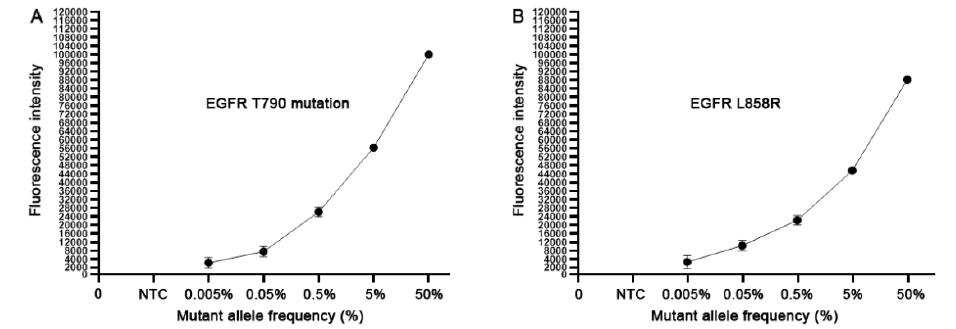
Figure 1. The analytical sensitivity of the CRISPR-Cas12a system. The serially diluted H1975 positive cell line DNA with different mutant allele frequency (%) of 790M ( A ) and L858R ( B ) in human normal genomic DNA was tested. Each concentration of the serially diluted positive cell line DNA was tested in triplicates for three times.